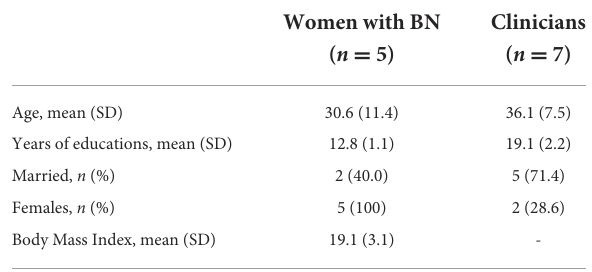
TABLE 1 Characteristics of